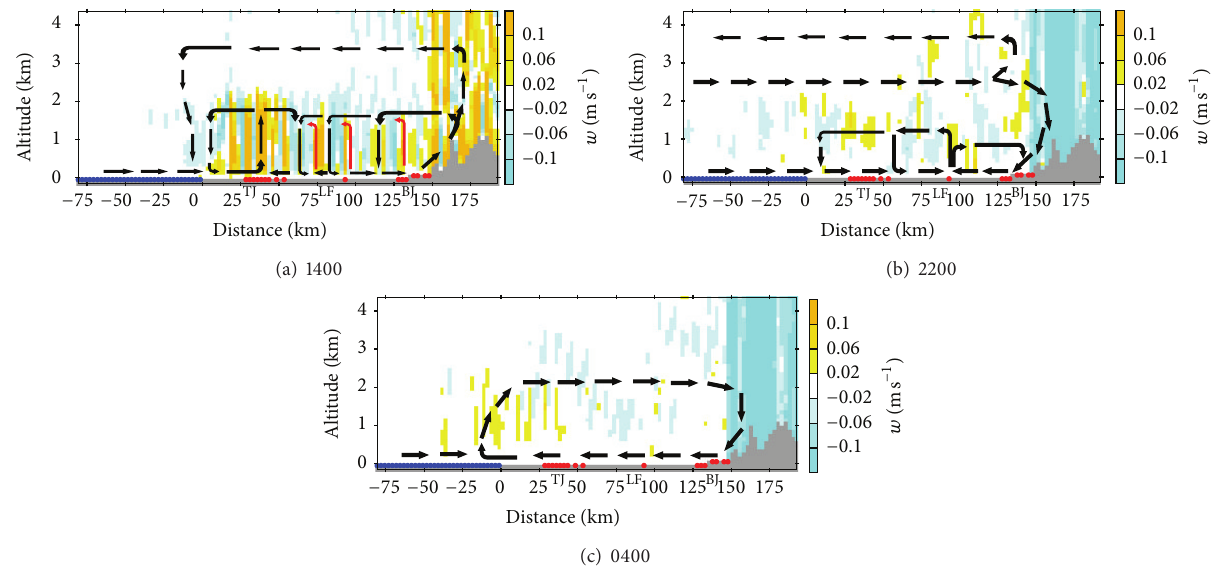
Figure 14: The schematic representation of the local circulations in the CNTL experiment, (a) 1400 LST 24 August, (b) 2200 LST 24 August, and (c) 0400 LST 25 August; the three cities from left to right are Tianjin (TJ), Langfang (LF), and Beijing (BJ), respectively. Please refer to Figure 6 for more details of the figure description. At 1400LST, except for the strong SLB circulation and MVB circulation, the upward motions of the smaller scale local circulations (i.e., UHI circulation) were indicated by the red arrows. (a) represents Figure 11(a) and (b) and (c) represent Figures 6(b) and 6(c), respectively.